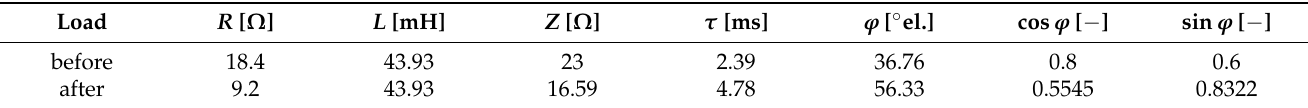
Table 1. Load parameters for steady states before and after load change.